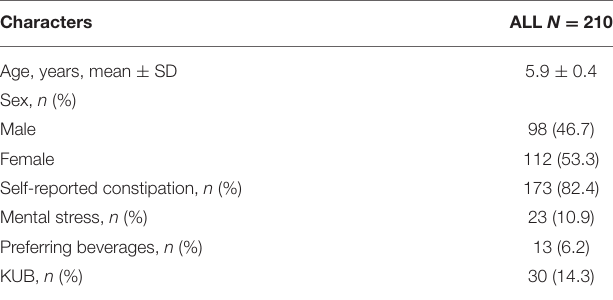
TABLE 1 | Clinical characteristics of the 210 patients with PEDUF.